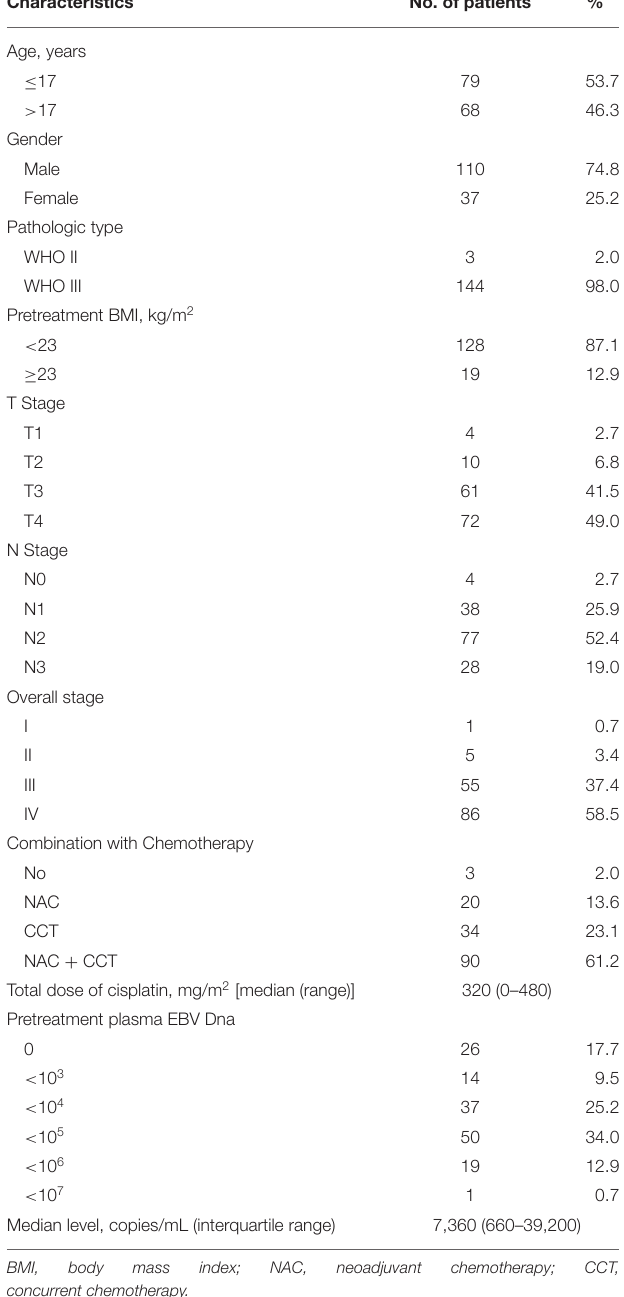
TABLE 1 | Clinical characteristics of 147 patients with children and adolescent nasopharyngeal carcinoma.